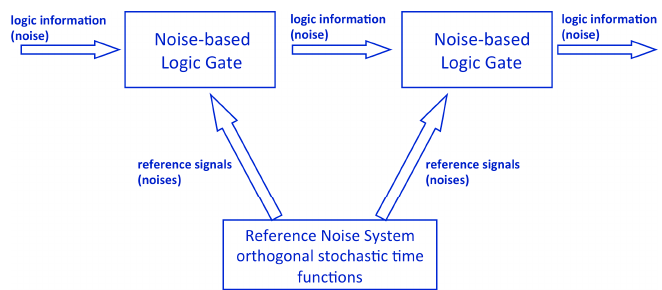
Figure 1. Generic noise-based logic hardware scheme.